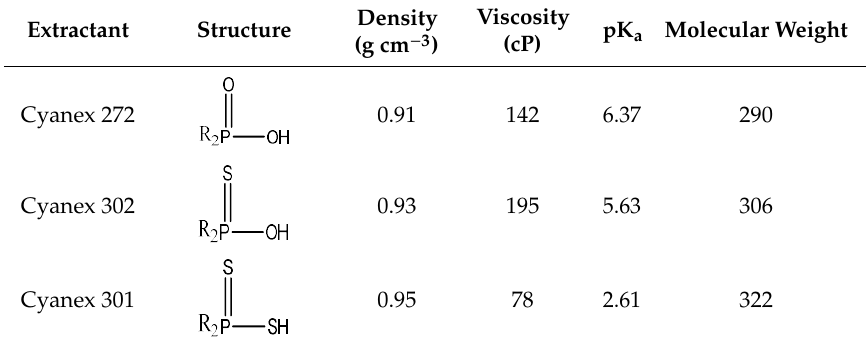
Table 1. Structure and properties of Cyanex 272, Cyanex 302 and Cyanex 301 at 24 °C [10,13]. Extractant Structure